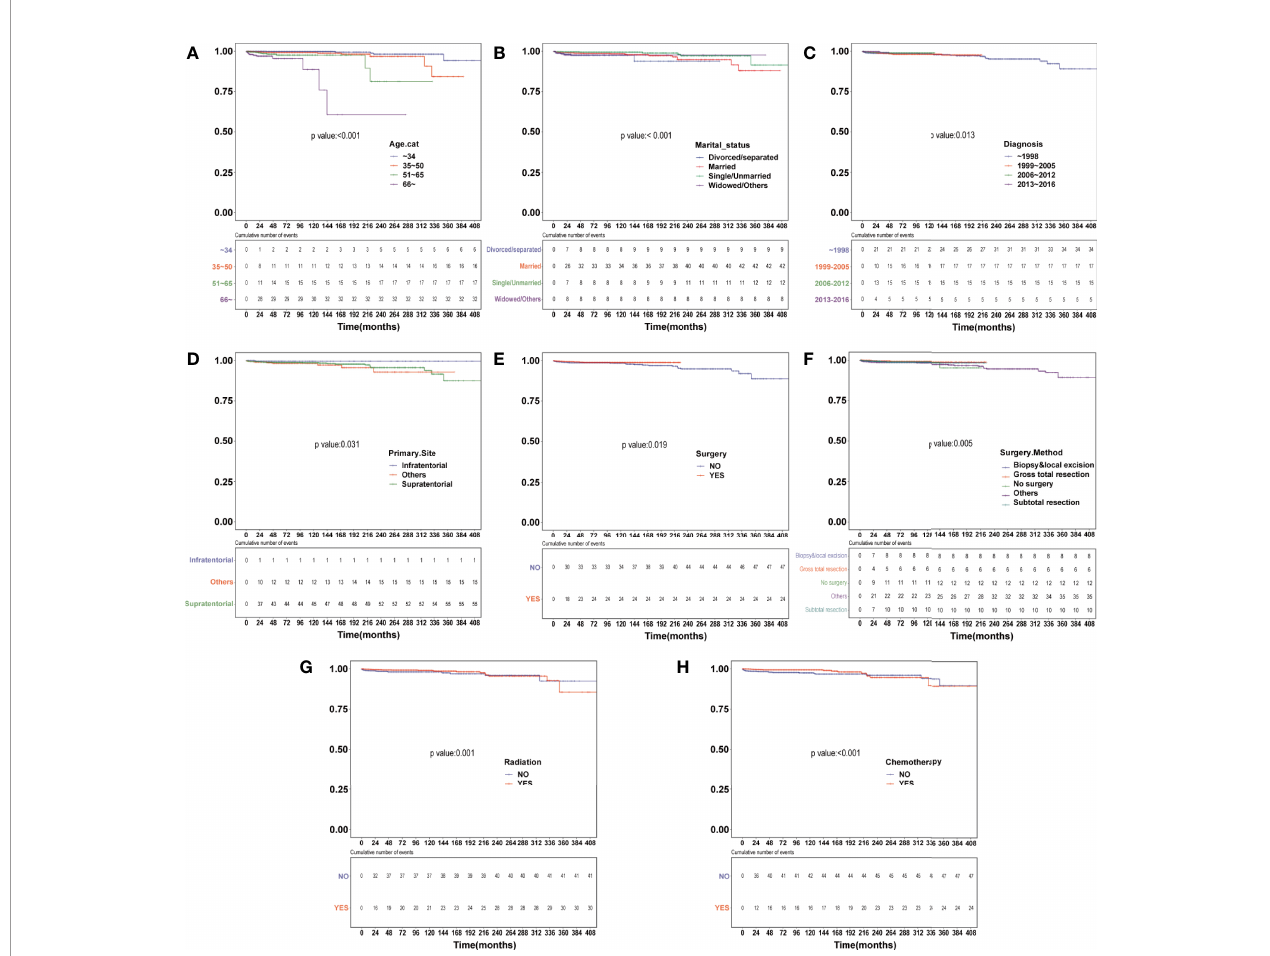
FIGURE 1 | Heart disease – speci fi c survival (HDSS) curves of anaplastic astrocytoma patients strati fi ed according to (A) age at diagnosis, (B) marital status, (C) year of diagnosis, (D) primary site, (E) surgery, (F) surgery method, (G) radiation and (H) chemotherapy based on Kaplan – Meier